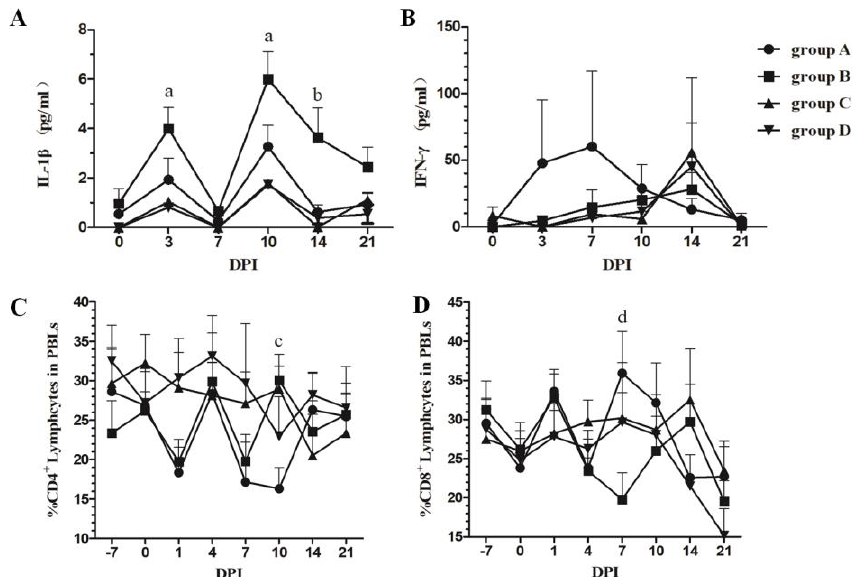
Figure 2. Concentrations of serum IL-1 β and IFN- γ and changes in the percentage of T lymphocyte subsets in PBLs. Serum concentrations of IL-1 β ( A ) and IFN- γ ( B ) were measured using commercial ELISA kits (Cusabio, China); Changes in the T lymphocyte subset in PBLs for CD4 ( C ) and CD8 ( D ) expression were detected by flow cytometry. Each point represents the mean value (±S.D) generated from each group on different DPIs. a, group B is higher significantly than groups C and D ( p < 0.05); b, group B is higher significantly than groups A and C ( p < 0.05); c, group A is lower significantly than groups B and C ( p < 0.05); d, group A is higher significantly than group B ( p < 0.05).